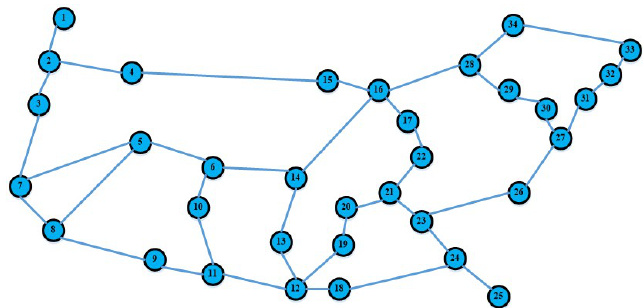
Figure 5. Internet2 OS3E topology.